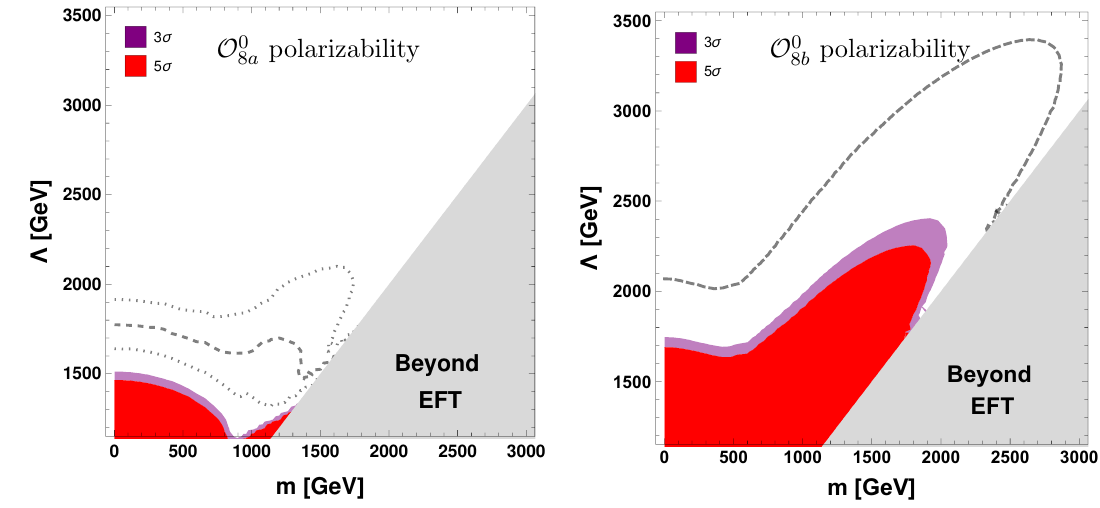
Figure 2 . Sensitivity of the exclusive diphoton channel to a spin-0 dark particle with dimension-8 polarizability with coe(cid:14)cient c 0 ((cid:3)) = 10, represented in the mass-cuto(cid:11) plane, and assuming 8 a; 8 b p s = 13 TeV, L = 300 fb (cid:0) 1 . The dashed lines correspond to the 5 (cid:27) sensitivity in presence of N = 5 copies of the dark particle. The two dotted lines corresponds to the 5 (cid:27) sensitivities for the spin-0 state of the neutral string assuming q = 1 and q = 2, and taking (cid:3) = l (cid:0) 1 s